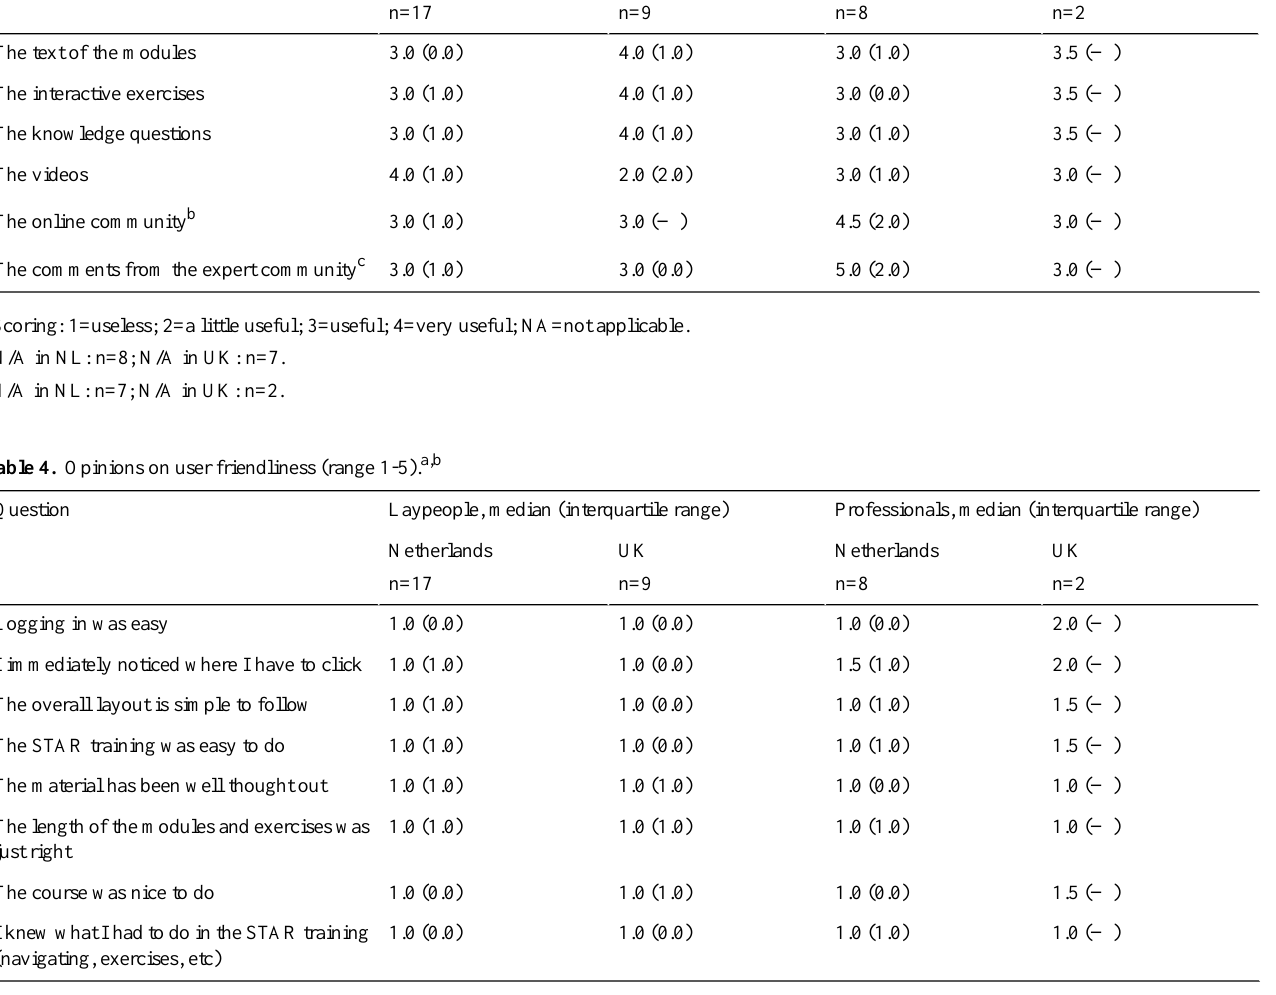
Professionals, median (interquartile range)Laypeople, median (interquartile range)Element